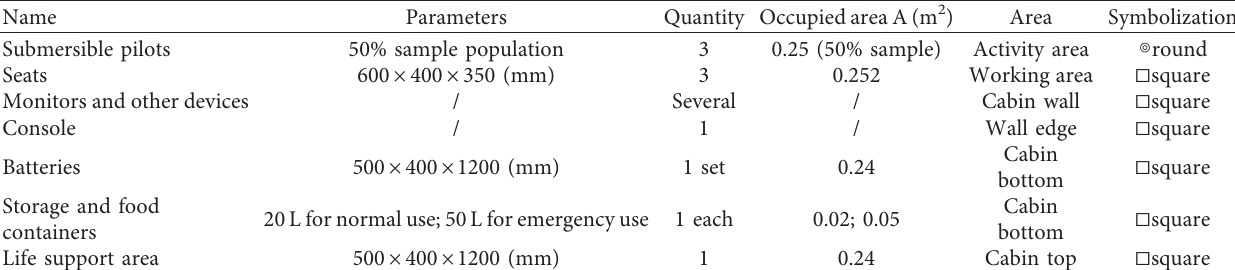
Table 2: Objects in the spherical cabin and occupied area.